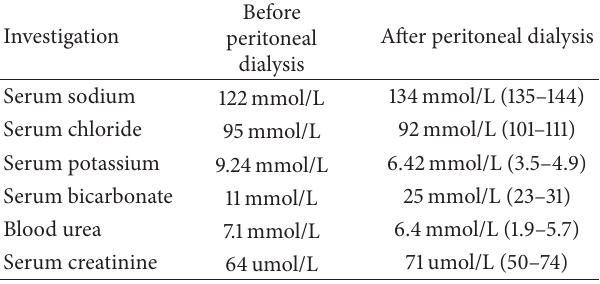
Table 1: Effect of peritoneal dialysis on blood chemistry.